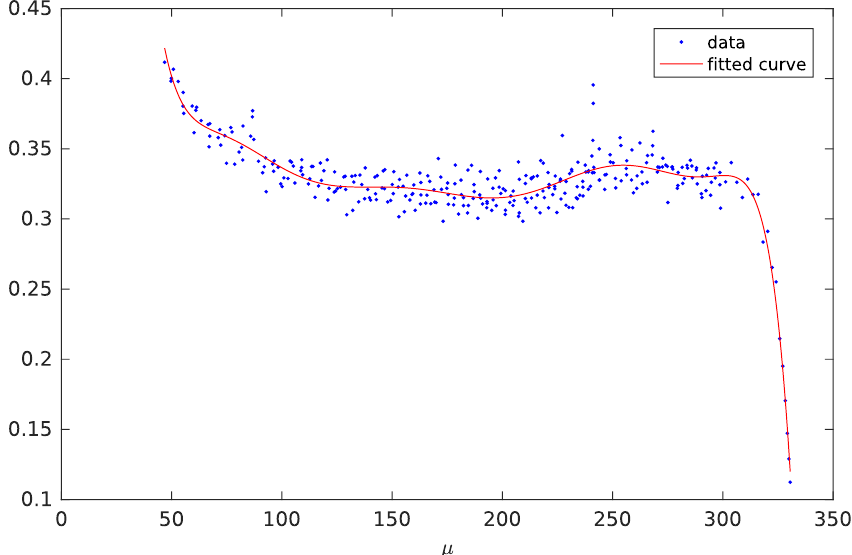
Figure 2. Plot of noise model that describes the Gaussian variance as function of the mean value (transformed intensity) in Freeman–Tukey space with SSE = 0.0391 and RMSE =